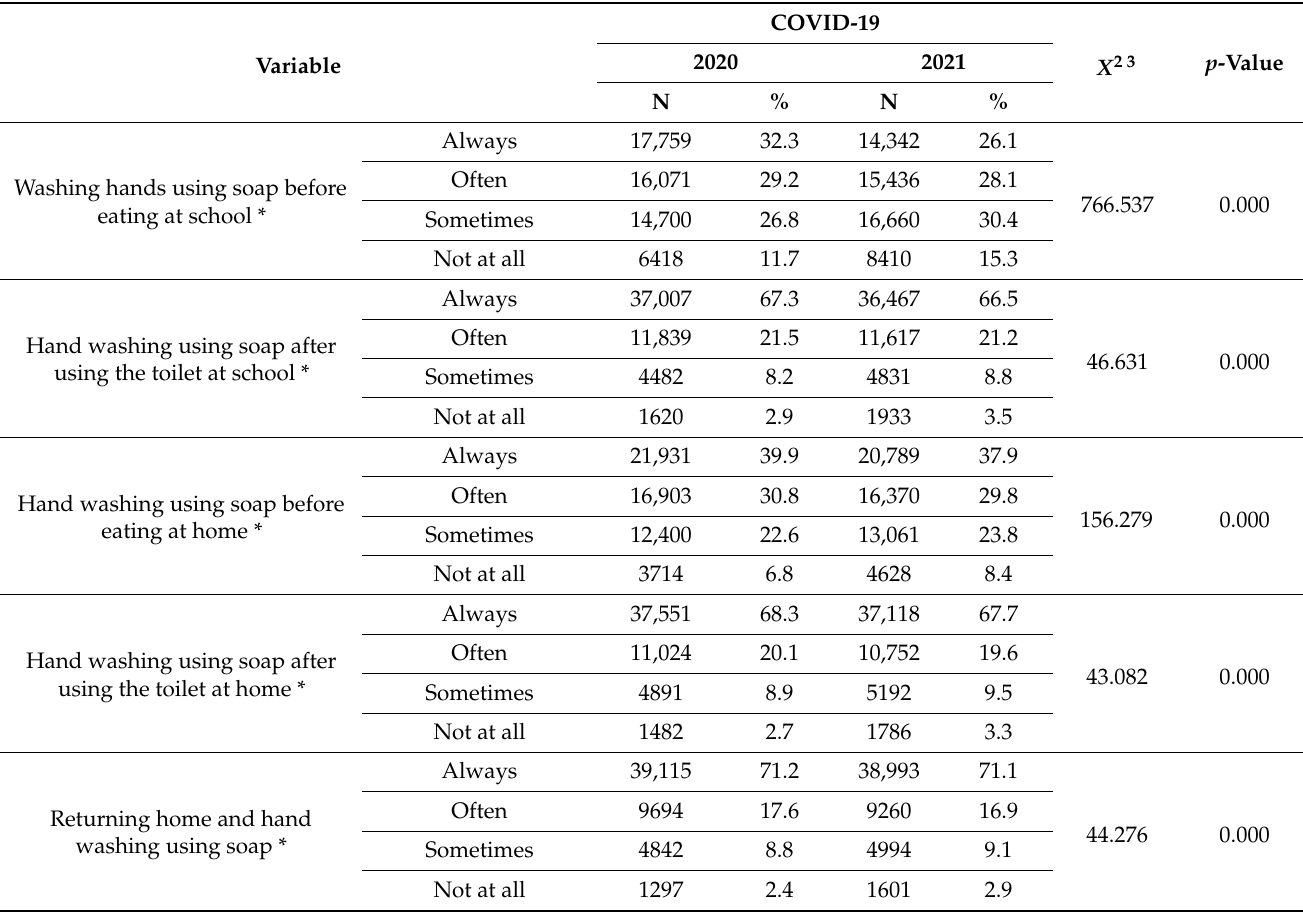
Table 4. Changes in personal hygiene habits due to the COVID-19 outbreak.